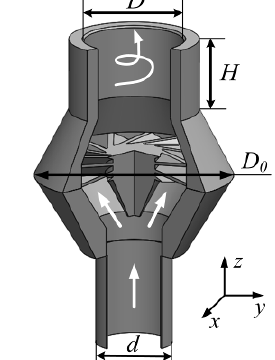
Fig. 1. The experimental